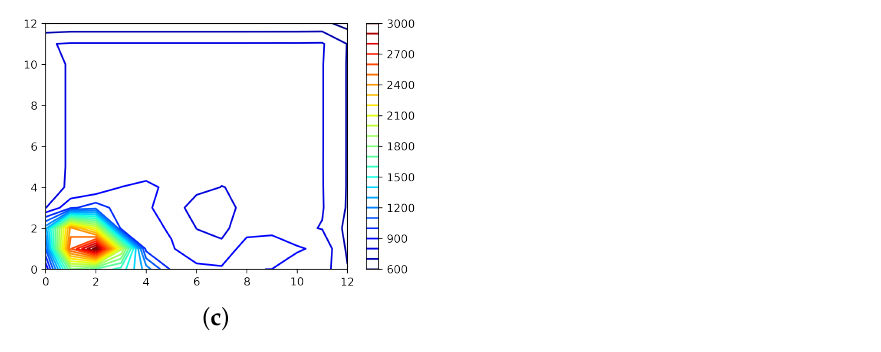
Figure 6. Feature spectrum of 20 µ g/L ( a ) rhodamine B, ( b ) salicylic acid, and ( c ) phenol.